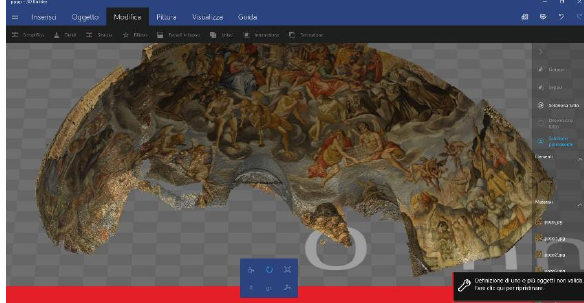
Figure 13. The frescoes vault photogrammetric